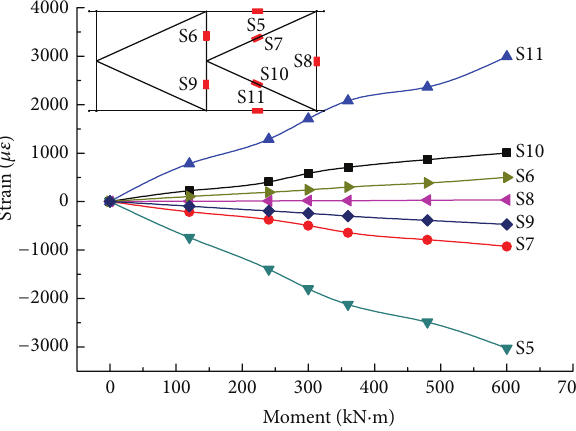
Figure 16: The relationship between the equivalent bending moments and experimental values of strain for